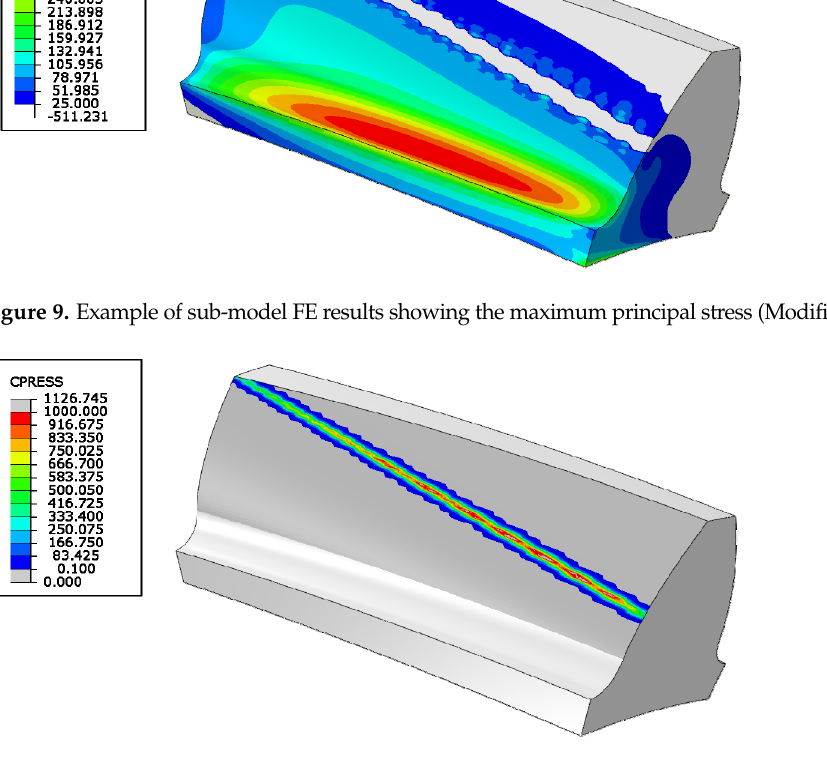
Figure 10. Example of sub-model FE results showing the contact pressure (Modified Geometry). Table 3. maximum tooth root stress estimated by the FE models.